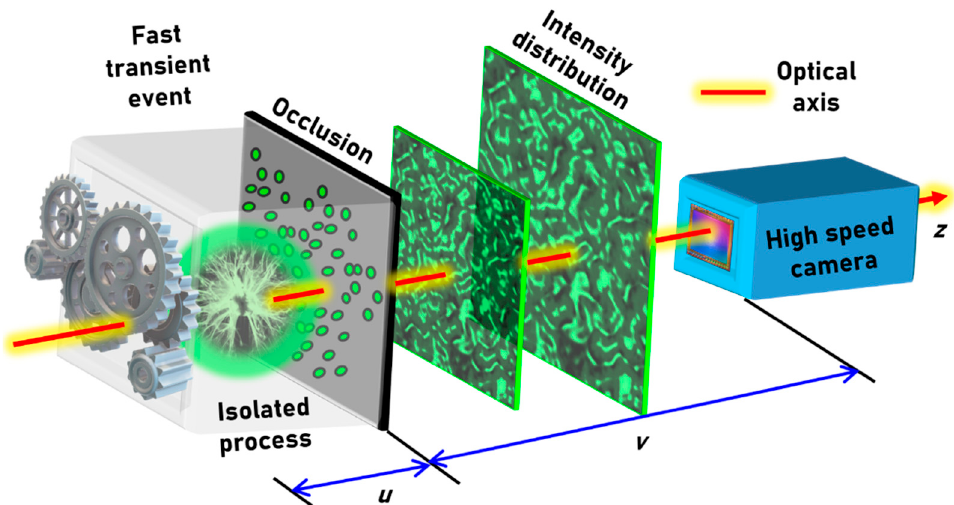
Figure 1. Optical configuration of light collection from an isolated fast transient industrial process through an occlusion (metal window with punched holes) by a high-speed camera.